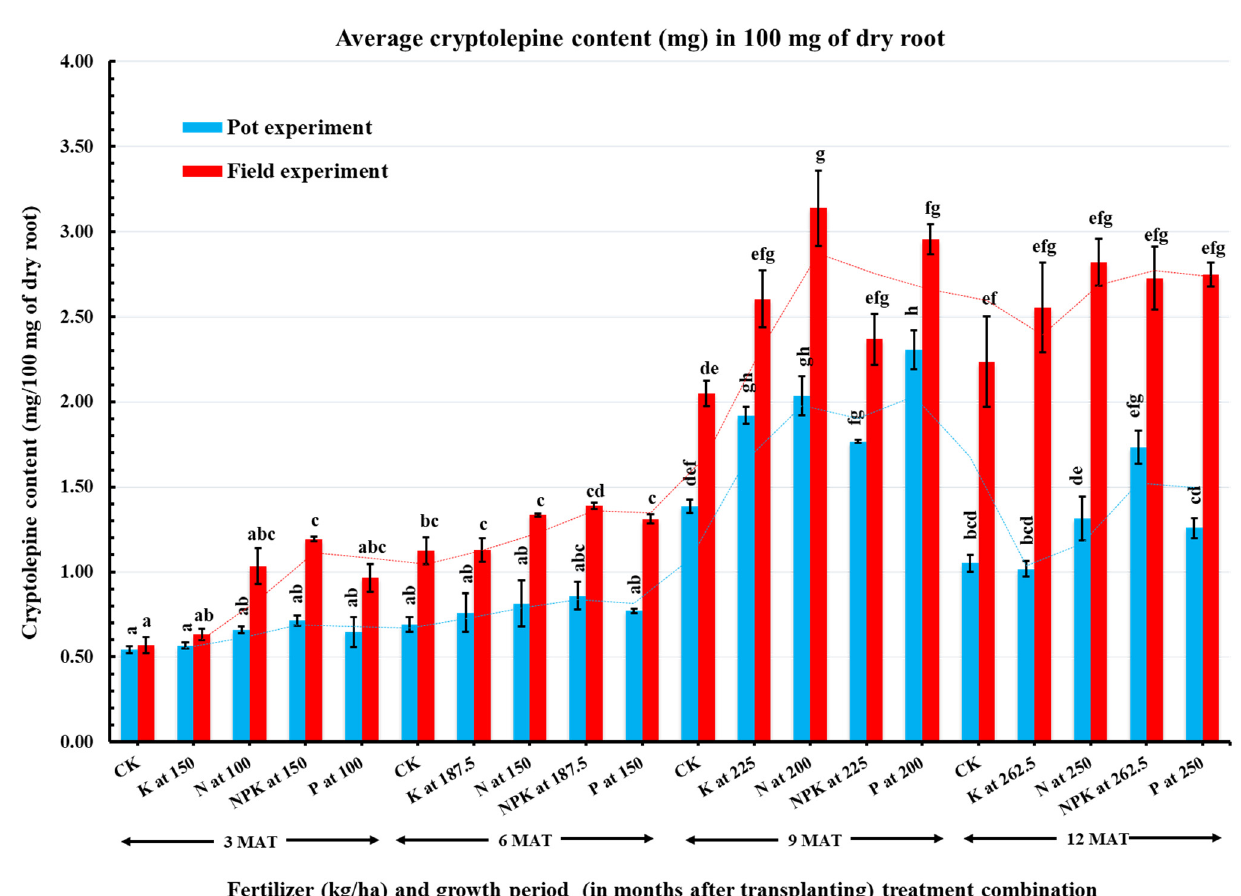
Figure 1. Cryptolepine content in roots of C. sanguinolenta in response to fertilizer treatments within four growth periods. The growth periods/plant ages are in months after transplanting (MAT), and CK, K, N, NPK, and P denote the treatments applied: Control, Potassium, Nitrogen, combined NPK, and Phosphorus, respectively. Bars represent the mean of three replicates, and error bars are the SEM. Bars having the same color followed by different letters are significantly different at p ≤ 0.05 based on the LSD test.